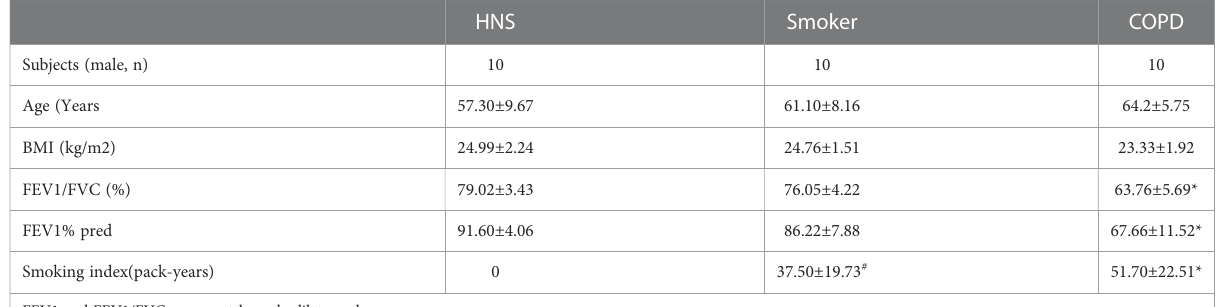
TABLE 1 Clinical Characteristics of the study